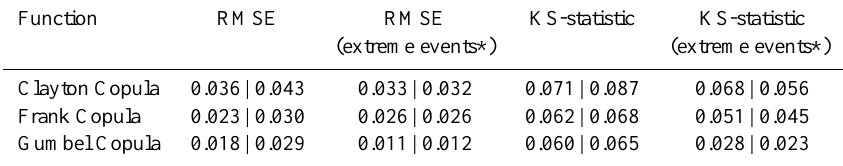
Table 2. RMSEs and values for the KS-statistic from comparing theoretical and empirical joint probabilities (Cuxhaven | H¨ornum). Function